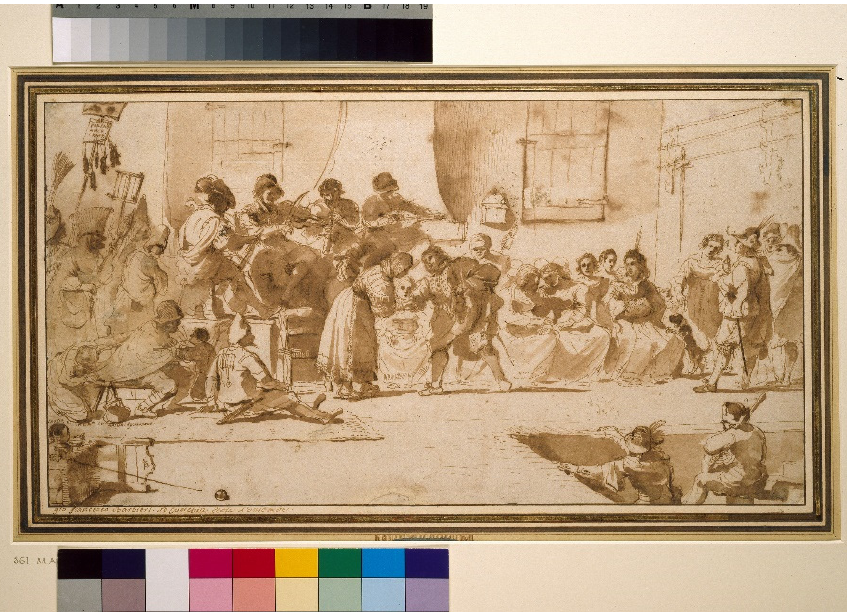
Figure 5. Guercino. Tavern Scene (drawing), the Ashmolean Museum, Oxford. Photo: © Ashmolean Image Library.